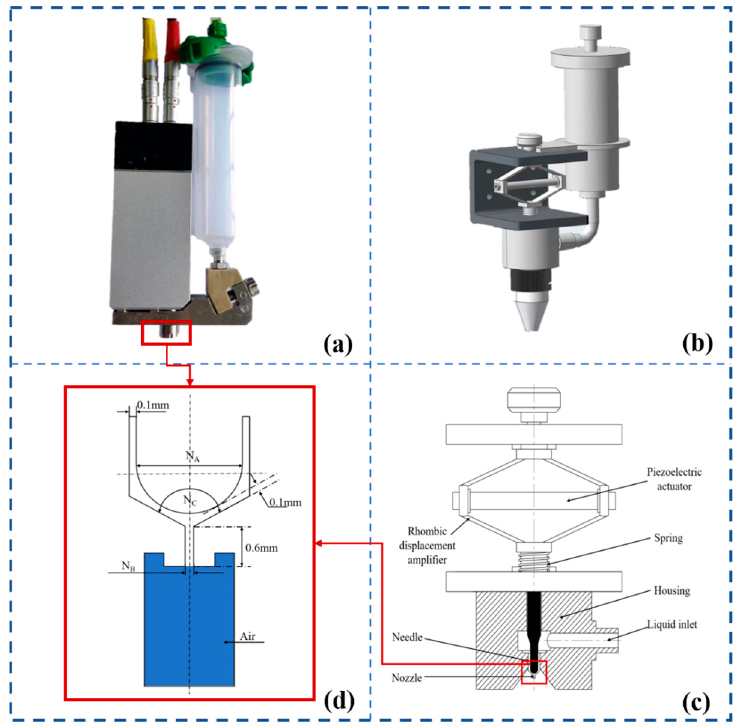
Figure 1. Design of the studied piezoelectric ejection system and dimensions of core components (nozzle and needle). ( a ) Physical drawings, ( b ) three-dimensional drawings, ( c ) two-dimensional simplified drawings, ( d ) two-dimensional drawings of core